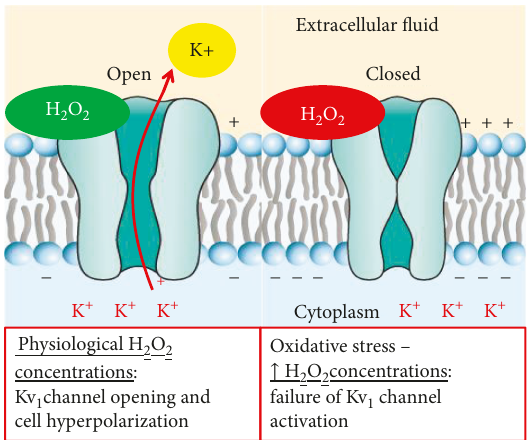
Figure 6: Physiological and pathophysiological roles of H2O2 on voltage-dependent potassium channel